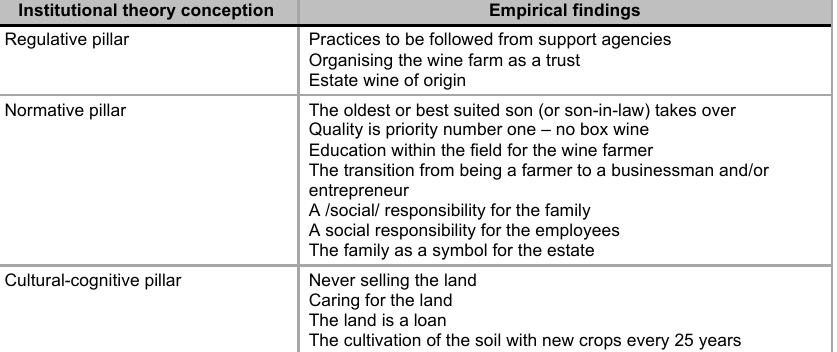
An overview of empirical findings in relation to the three institutional pillars Institutional theory conception Empirical